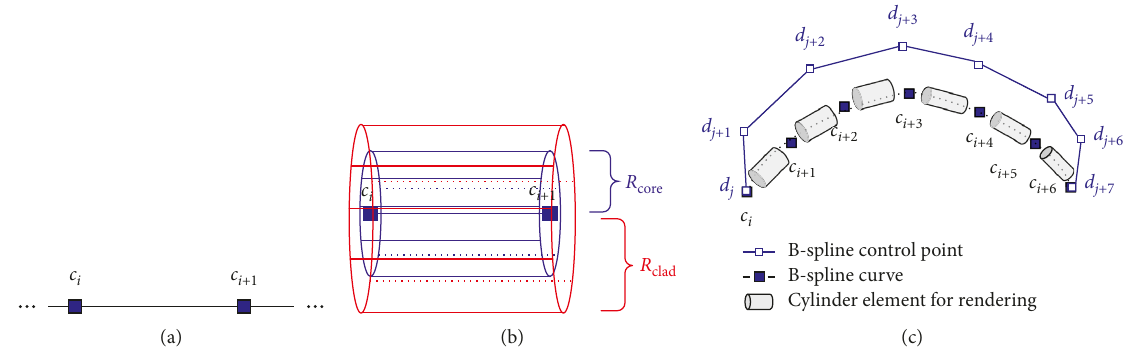
Figure 5: Hollow-cylinder-shaped fiber model for virtual half-cone simulation. (a) Initial center points for fiber longitudinal central axis. (b) Hollow-cylindrical shape assigned for each center point pair. (c) Deformation of fiber using cantilever beam analogy.